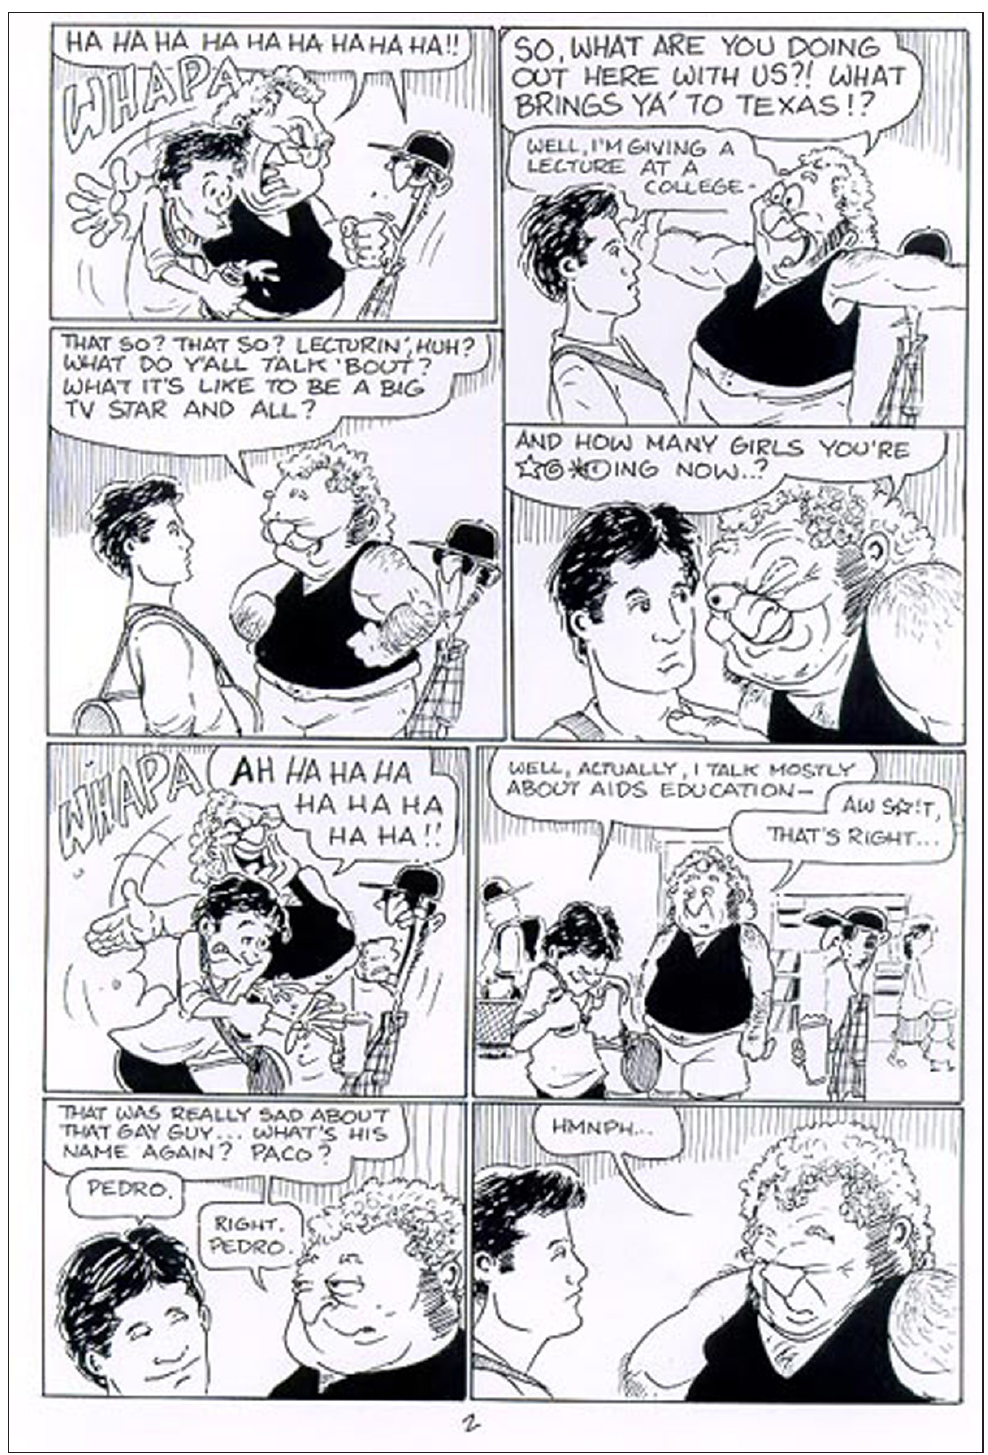
Figure 2: Too “goofy” for inclusion in Pedro and Me’s anniversary edition? This sequence by Judd Winick originally appeared on a former Henry Holt mini-site to support the release of the first edition of Pedro and Me . Judd Winick, Henry Holt defunct Pedro and Me site, still available at https://web.archive.org/web/20071018075021/http://www. captionbox.net/pedro/cutpages1.html. © 2000 Judd